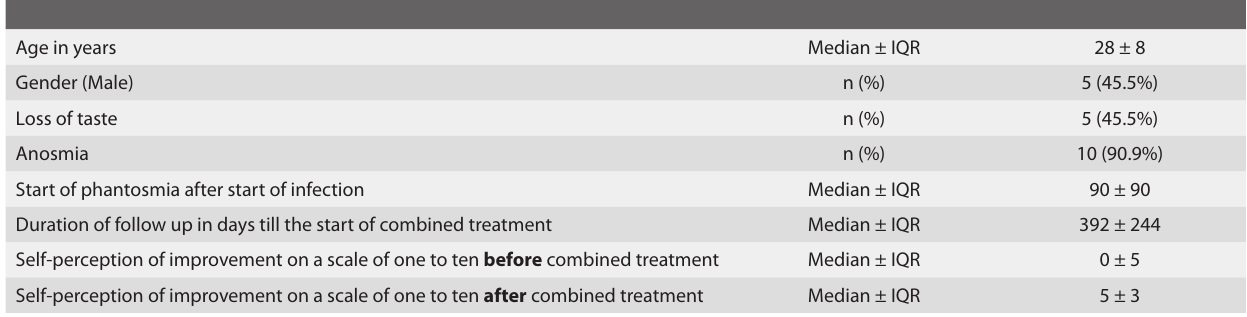
Data shown are frequencies; n (%), and median ± interquartile range